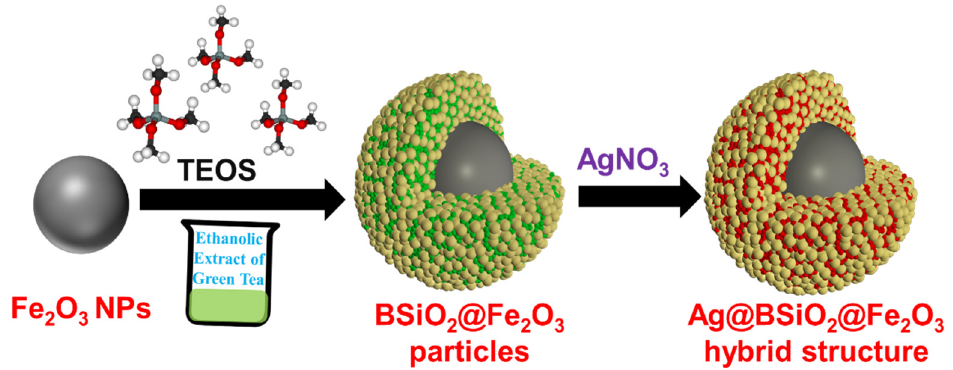
Figure 1. Schematics for the synthesis of silver-decorated biomolecule-entrapped SiO 2 -coated Fe 2 O 3 (Ag-BSiO 2 -Fe 2 O 3 ) hybrid structure.